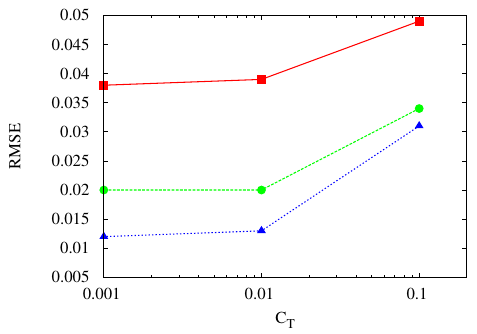
Fig. 6. RMSE obtained from experiments made with 10 5 (red), 4 × 10 5 (green) and 16 × 10 5 (blue) particles as a function of C T 4 × 10 5 (green) and 16 × 10 5 (blue) particles as a function of C T .